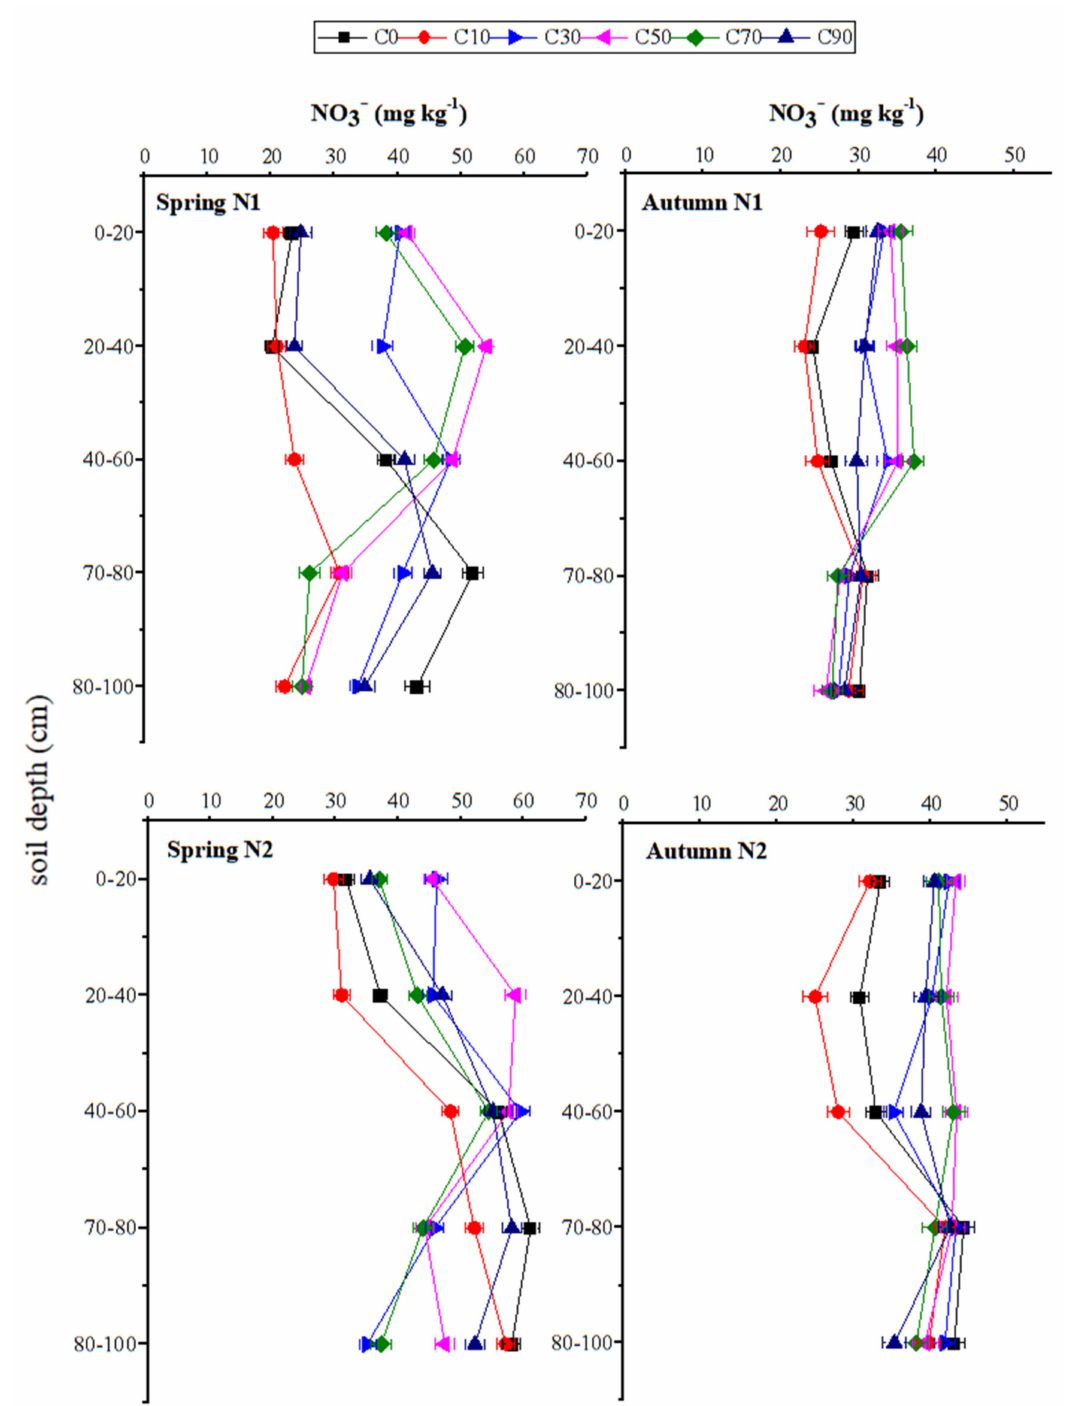
Figure 3. The distribution of NO 3 − at different soil depths for the N fertiliser (N1 and N2) and biochar (C0, C10, C30, C50, C70, and C90) treatments. Error bars represent standard